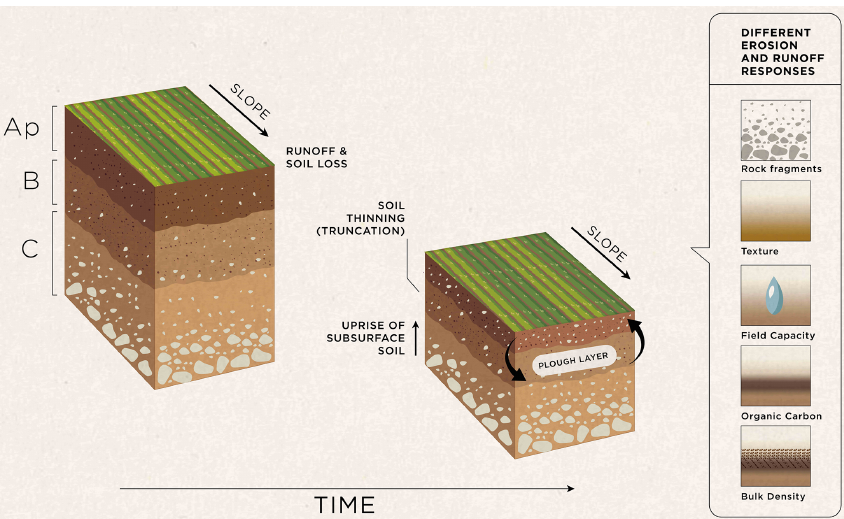
Figure 1. Modelling concept: selective soil erosion processes alter topsoil properties, which are then mixed with the underlying substrata as the soil profile thins. Updated soil properties for the plough layer are used as model inputs for the following time